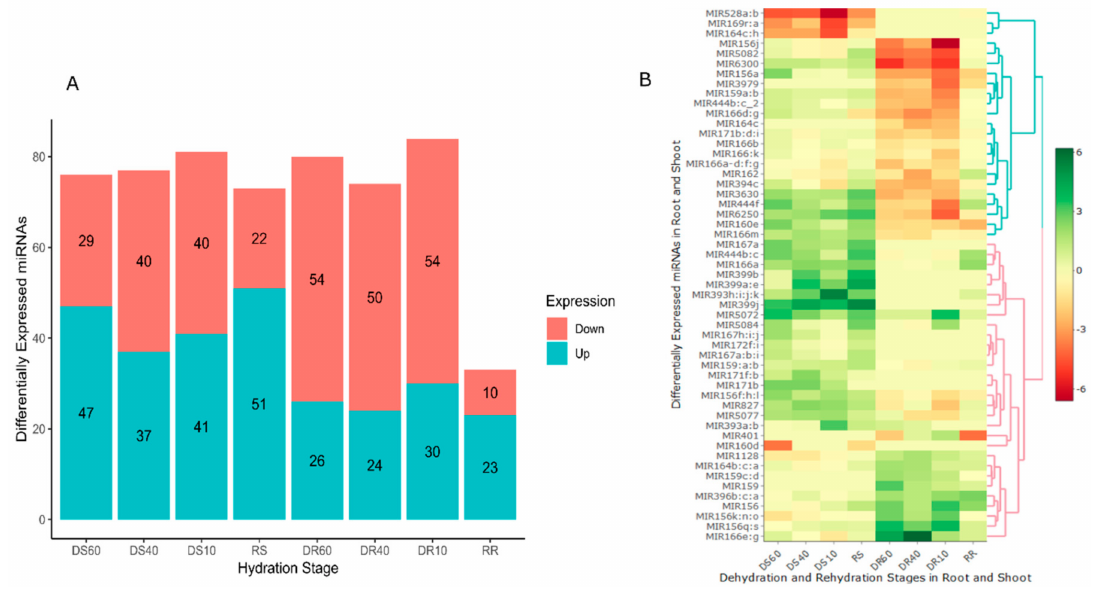
Figure 2. Differentially expressed miRNAs in shoots and roots under dehydration stress. ( A ) Bar graph showing disparate expression between shoot and roots. ( B ) Heatmap showing differentially expressed genes between shoots and roots at the different dehydration, desiccation, and rehydration stages. DS: Dehydrated Shoot, DR: Dehydrated Root, RS: Rehydrated Shoot, RR: Rehydrated